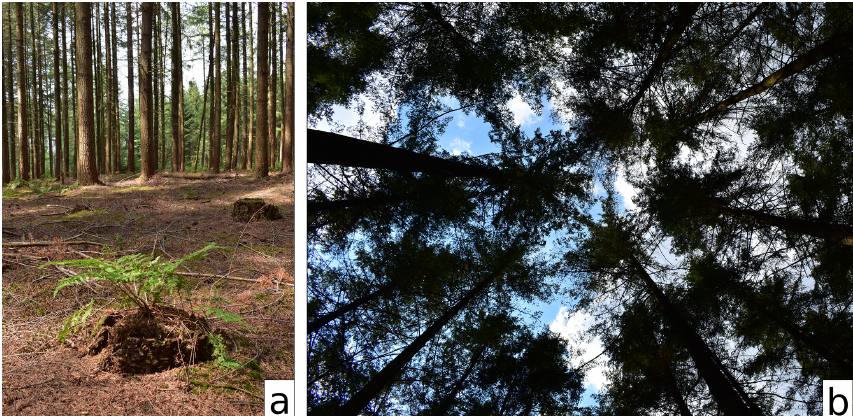
Figure 2. The forest floor, showing the open understory (a) and a sky view from below (b) , showing the more dense canopy top. Photos taken in July